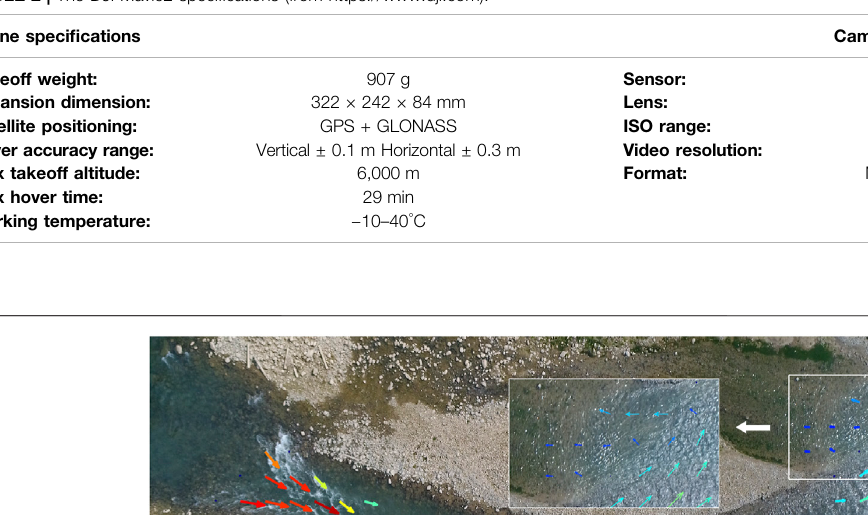
Frontiers in Earth Science |